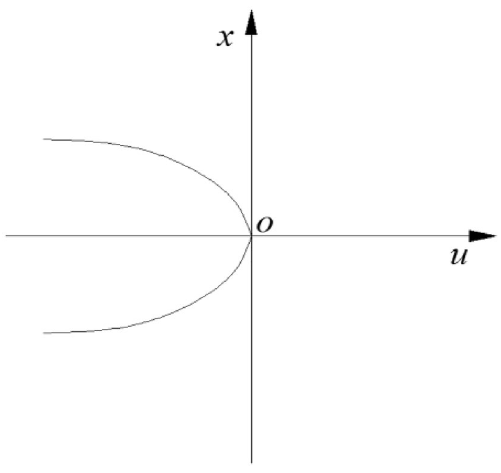
Figure 10. Variation of x with u in a singularity